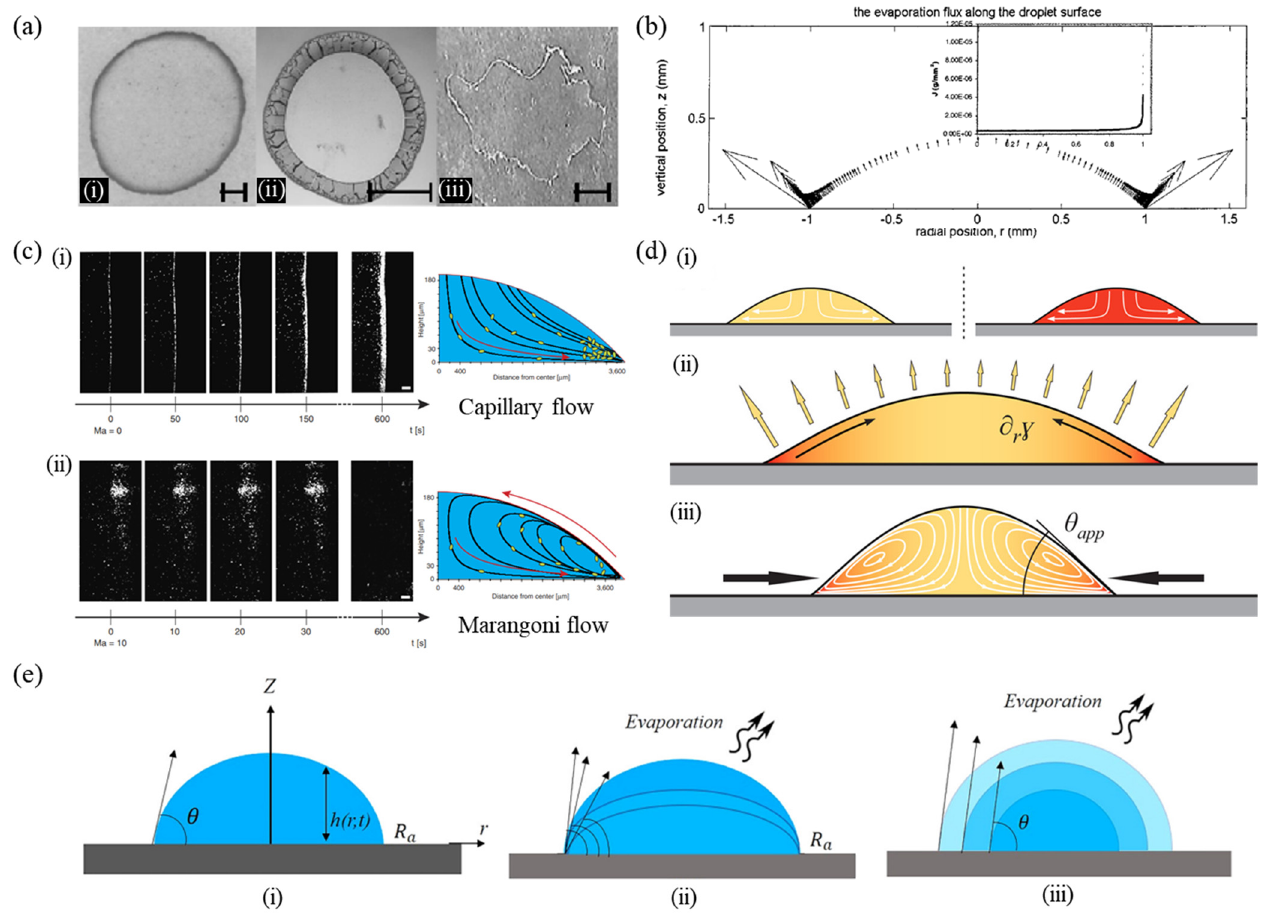
Figure 1. ( a ) Dried patterns of (i) coffee stain, (ii) colloidal microspheres, and (iii) salt deposit. The scale bar is 1 cm (reproduced with permission from ref. [30]. Copyright 2000 American Physical Society). ( b ) Evaporation flux along the droplet surface. The inset represents the magnitude of the evaporation flux along the droplet surface (reproduced with permission from ref. [31].